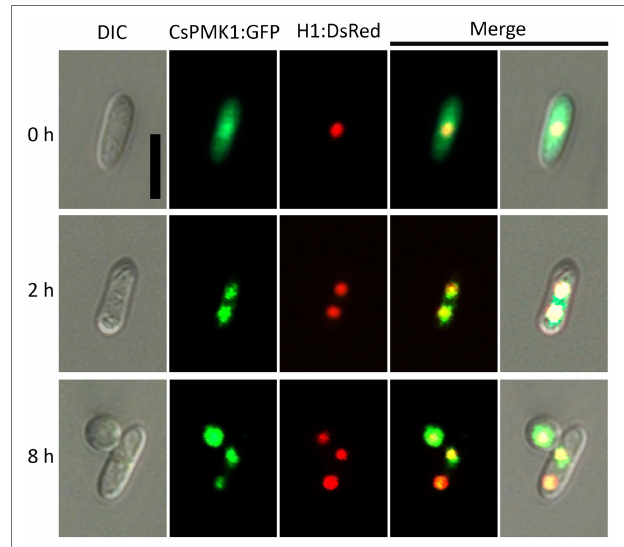
FIGURE 7 | Expression and localization of CsPMK1:GFP fusion protein in Colletotrichum scovillei . Conidia obtained from a transformant expressing H1:RFP and CsPMK1:GFP were placed on the hydrophobic surface of coverslips and incubated at 25 ° C. Scale bar, 10 μ